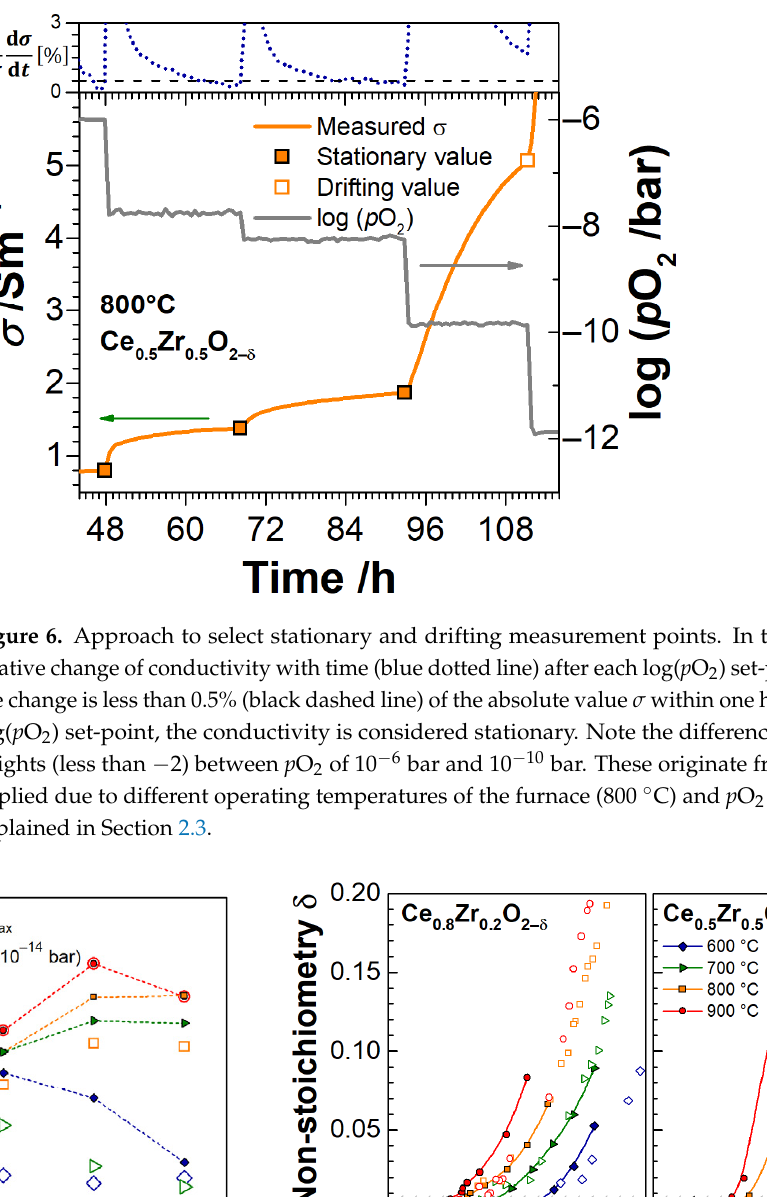
anticipated predominantly surface-controlled redox kinetics in thin films, in contrast to mainly diffusion-controlled processes in bulk materials [41].